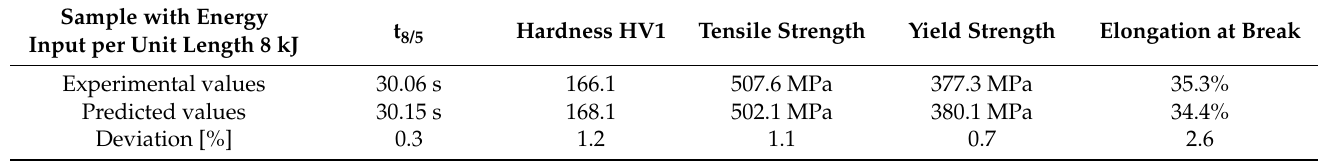
Table 4. Comparison of measured and calculated t 8/5 cooling times and mechanical properties.